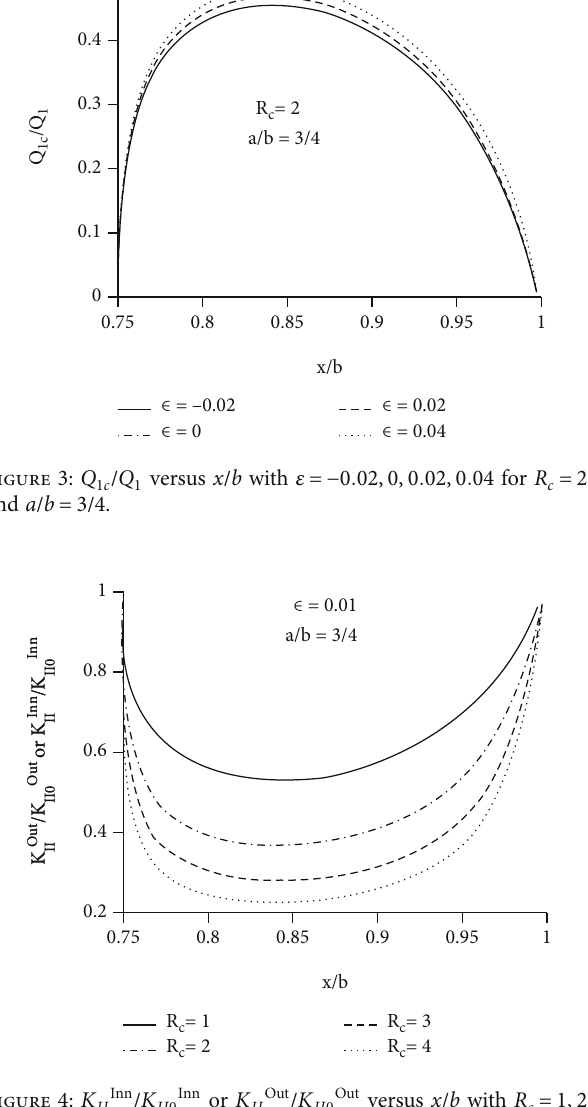
Figure 6: S Inn / S MPa, and a / b = 1/4